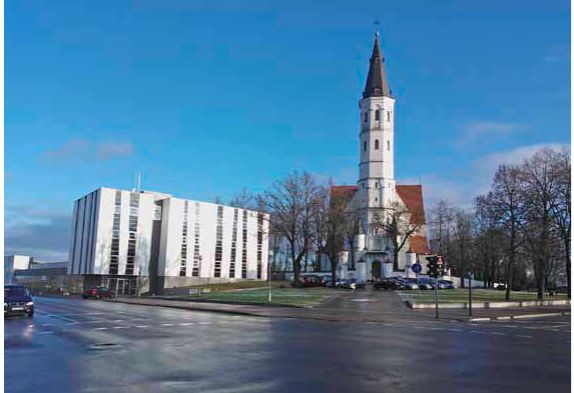
fig. 13. The church tower is a distinct semantic sign of the urban identity of the city of Šiauliai, but the new building with its architectural forms, scale and size diminish its significance. E. ramanauskas